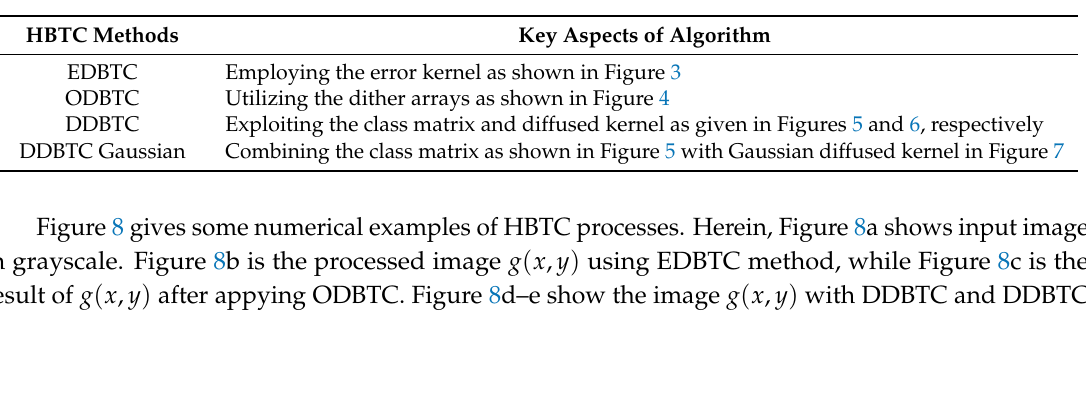
Table 1. Summary of key aspects over various HBTC techniques.